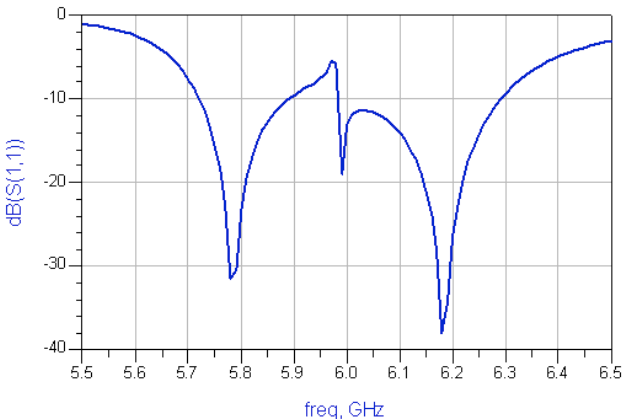
Figure11. Reflection co-efficient S11